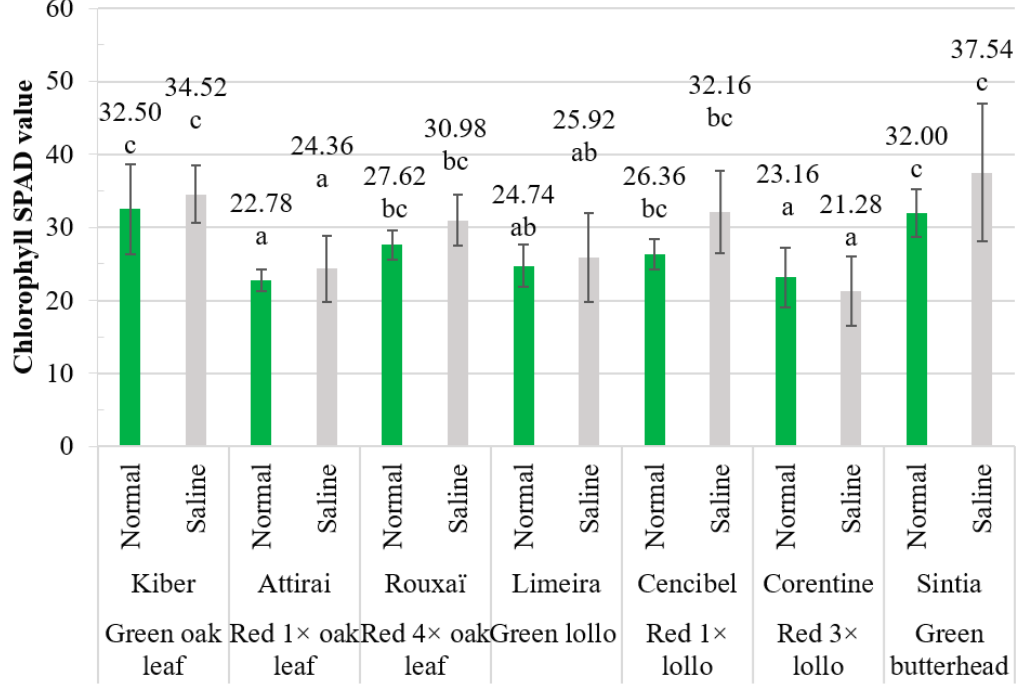
Figure 2. Chlorophyll content (SPAD value) of different cultivars of lettuce grown in saline and normal conditions (Games–Howell’s; p < 0.05). Different letters indicate significant differences among the treatments at p < 0.05 by Games-Howell’s test.